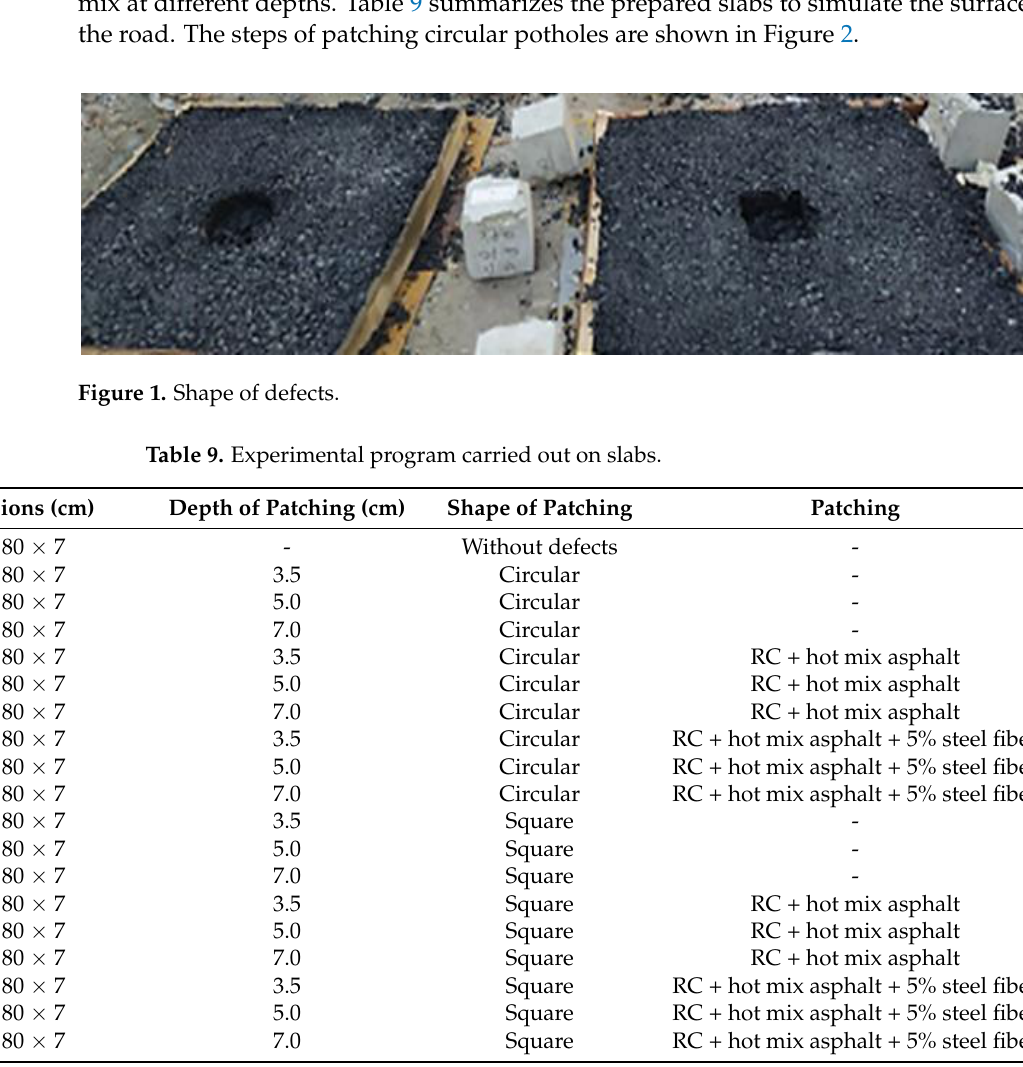
Figure 2. Steps of patching circular potholes.